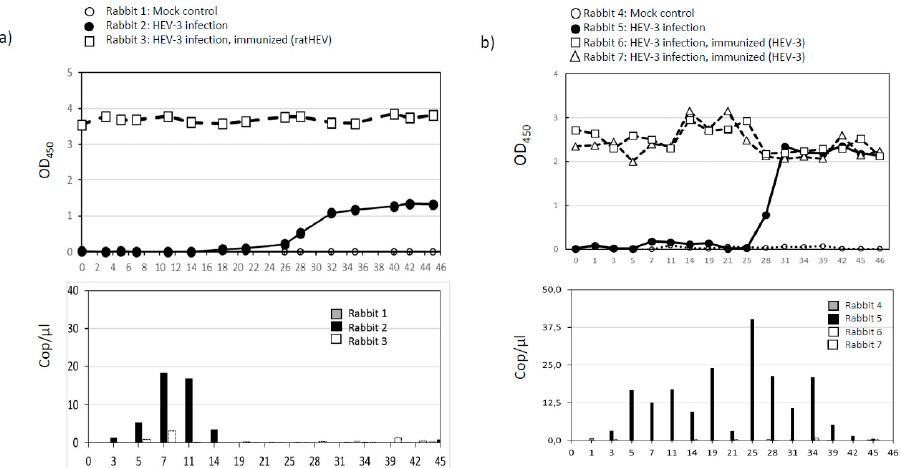
Figure 1. HEV-3 challenge of immunized and naïve European rabbits and induction of protective immunity by immunization with ratHEV capsid protein derivative ( a ) or HEV-3 capsid protein derivative ( b ). ( a ) Immunization with ratHEV capsid protein derivative (ratHEV-Ctr) and subsequent challenge with wild-boar derived HEV-3. [ ] one non-vaccinated rabbit (Rabbit 2) inoculated with HEV-3; [ (cid:3) ] rabbit 3 immunized with a C-terminal segment of ratHEV capsid protein derivative